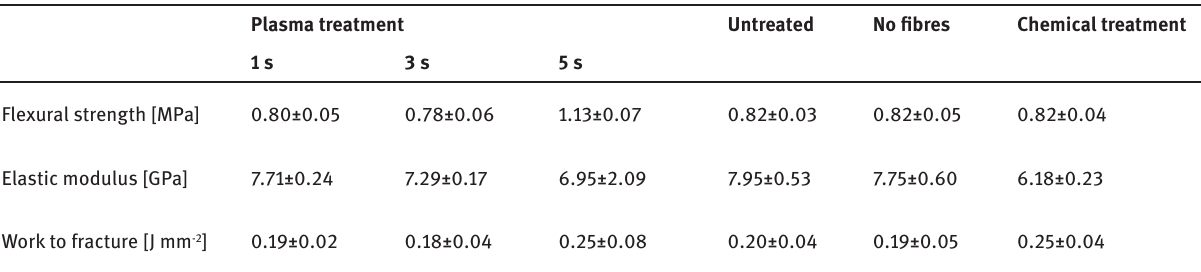
Table 2: Mechanical parameters of the fibre-reinforced concrete sample after 13 hours of hardening for various surface treatments of the PP